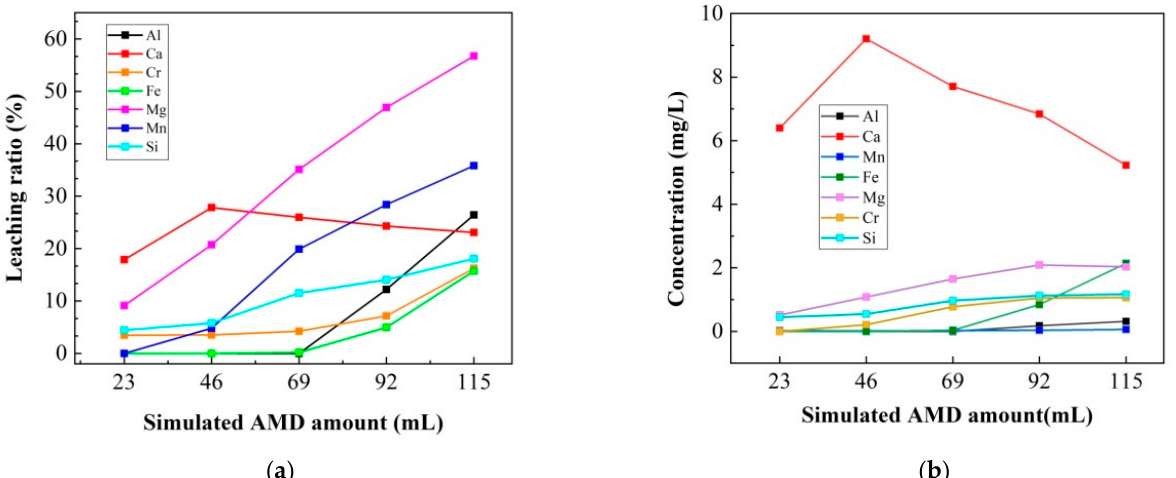
Figure 4. Leaching feature during the neutralization process, ( a ) leaching ratios; ( b ) leaching con- centrations. Ca-, Mg-, Si-, Al-bearing components had been studied extensively in regards to their leaching behaviors. It was reported that the Mg-, Ca-bearing constituents in steel slag contribute hugely to the short-term acid neutralization process, while Si/Al-bearing constituents discharge alkaline materials over a longer period of time due to their lower dissolution rate [25]. Slag leach- ing experiments conducted by HCl (0.1 M) also confirmed that CaO was more active than other Ca-containing minerals, its leaching ratio was more than 80%; followed by was silicates, its leaching ratio was more than 45%; then were the aluminates and ferrite, their leaching ratios were less than 30% [30].